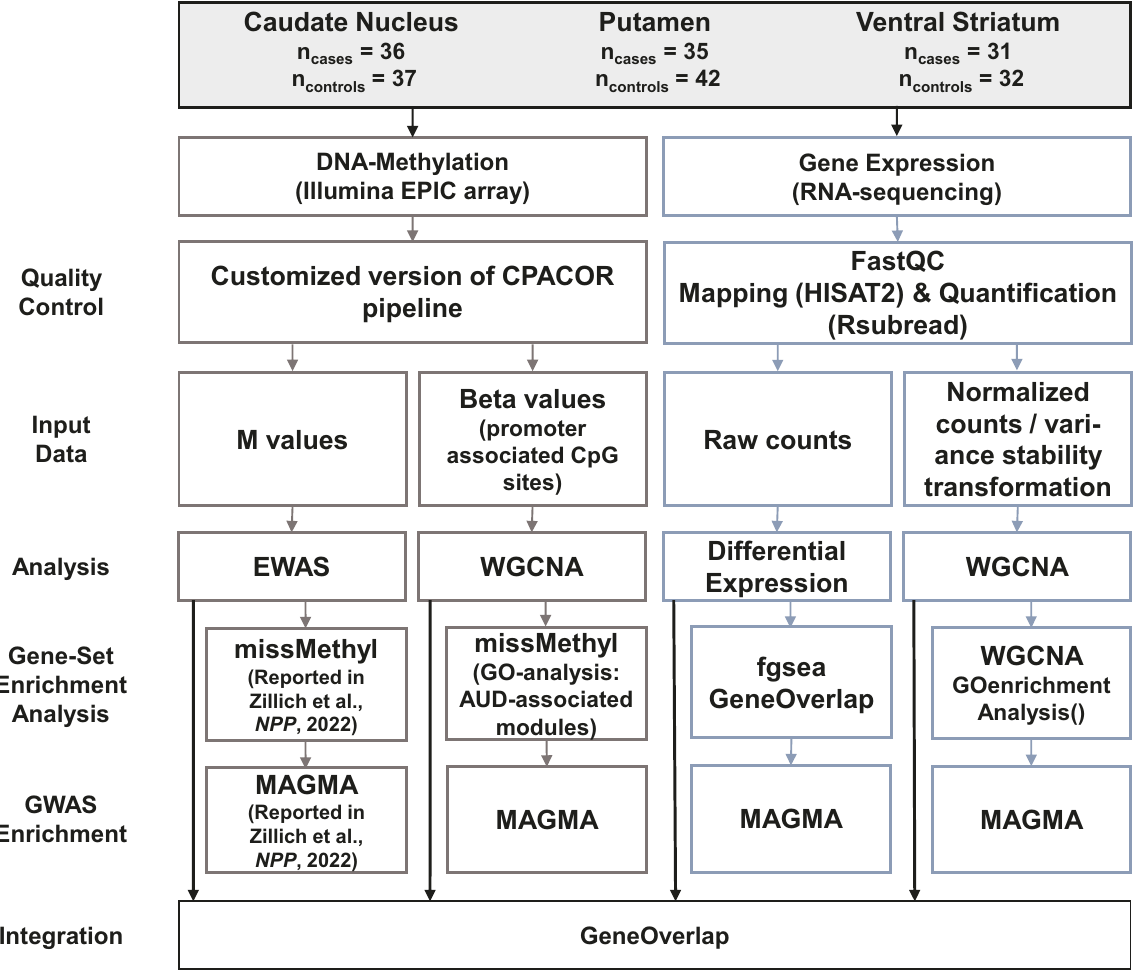
Fig. 1 Analysis Work fl ow. Analysis work fl ow of the present